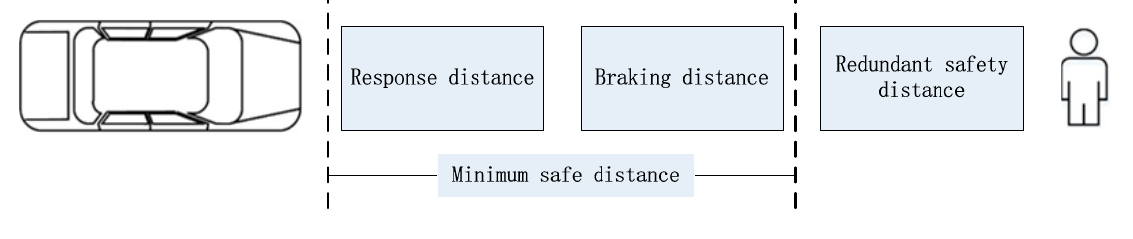
Figure 7. Vehicle braking safety distance.